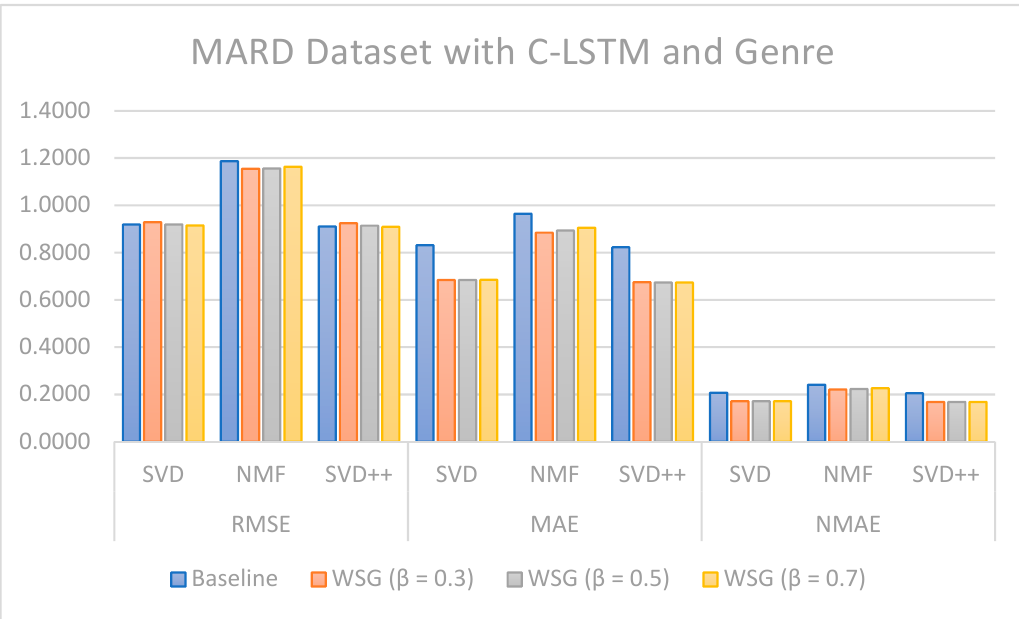
Figure 9. RMSE, MAE, and NMAE values with and without C-LSTM sentiment and genres-based model and different values of β on the MARD dataset. Table 7. RMSE, MAE, and NMAE values with and without L-CNN sentiment and genres-based model and different values of β on Amazon Movie dataset. RMSE